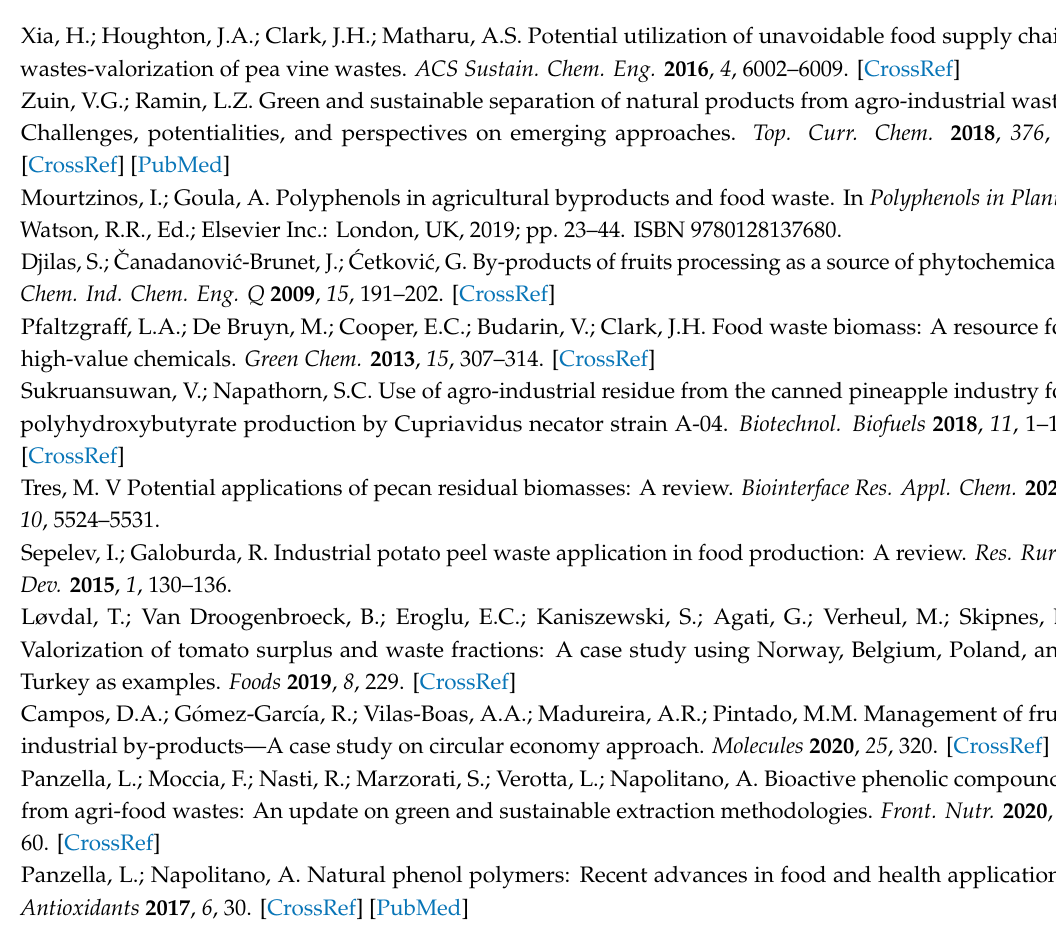
Figure S1. UV-Vis spectra of PolyCAF and PolyFER; Figure S2. CPNQS and CPPI NMR spectra of PolyFER; Figure S3. ATR-FTIR spectra of selected agri-food byproducts; Figure S4. UV-Vis spectra of the extractable fraction of selected agri-food byproducts; Figure S5. HPLC profile of the extractable fraction of pomegranate waste; Figure S6. UV-Vis spectra and HPLC profiles of the extractable fraction of chestnut tannins; Figure S7. UV-Vis spectra and HPLC profiles of the extractable fraction of quebracho tannins; Figure S8. Alkali degradation and alkali fusion mixture HPLC profiles of apple, orange, tomato and potato wastes; Figure S9. Alkali degradation and alkali fusion mixture HPLC profiles of pineapple, grape pomace and banana waste; Figure S10. Acid degradation mixture HPLC profiles of apple, orange, tomato and potato wastes; Figure S11. Acid degradation mixture HPLC profiles of pineapple, grape pomace and banana waste; Figure S12. Alkali degradation, alkali fusion and acid degradation mixture HPLC profiles of pecan nut shell; Figure S13. Possible chemical degradation pathways operating under alkaline and acid